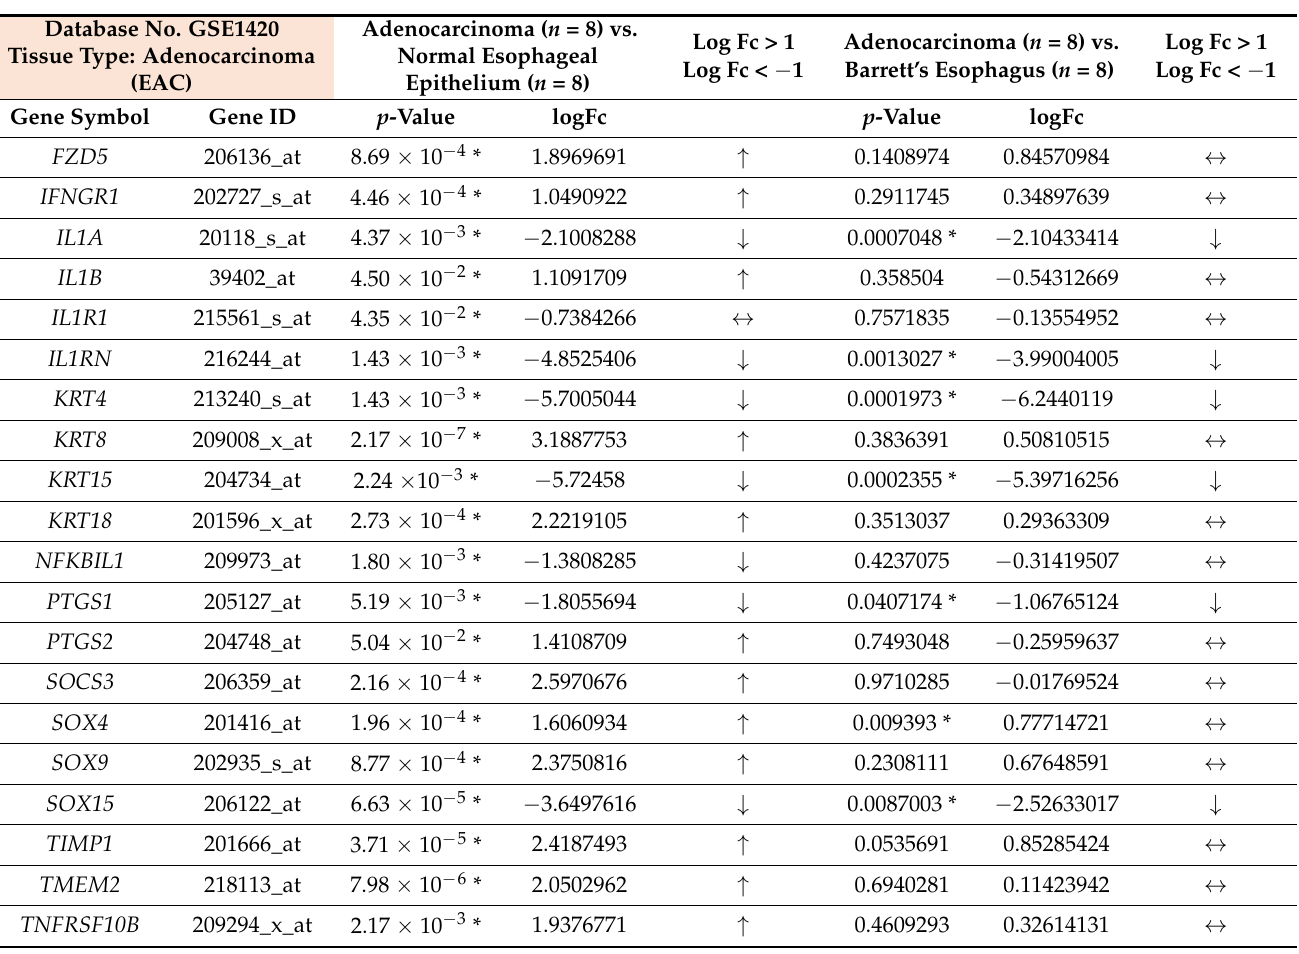
Table 1. Alterations in the expression of selected genes in human biopsies derived from patients with esophageal adenocarcinoma (EAC) compared to normal squamous epithelium or to Barrett’s esophagus (BE), based on an analysis of database no. GSE1420. Asterisk (*) indicates statistically significant differences with p < 0.05 in parallel with biologically significant logFC values lower than − 1 or higher than 1. An arrow up ( ↑ ) indicates upregulation of mRNA expression; an arrow down ( ↓ ) indicates downregulation of mRNA expression, and a double-sided arrow ( ↔ ) indicates no changes in mRNA expression.